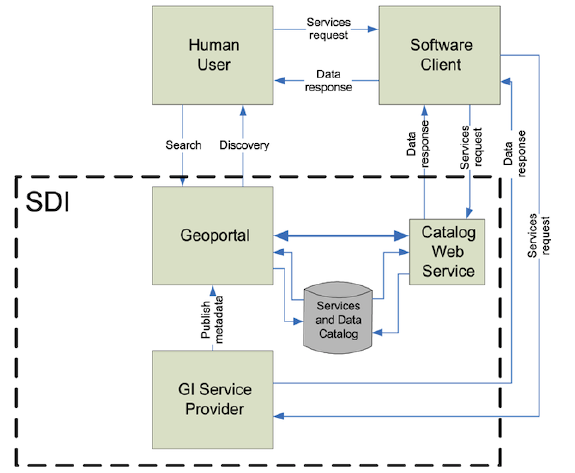
Figure 1. Architectural model of a traditional SDI. (Source: adapted Davis-Júnior and Alves [14]).